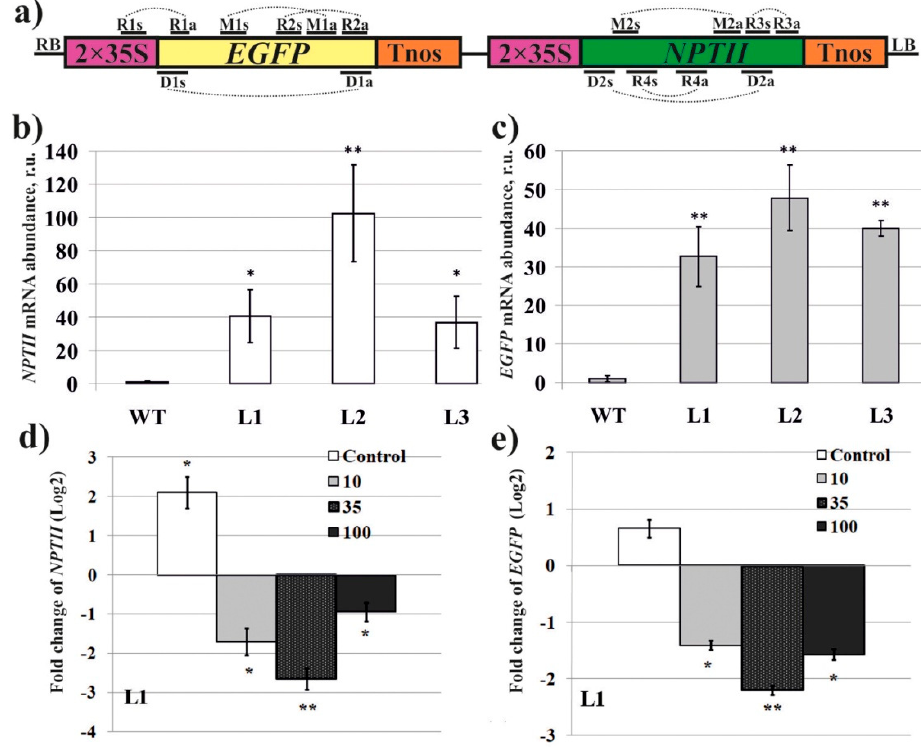
Figure 1. Characterization of transformed A. thaliana lines, and investigation of the dsRNA concentration effect. ( a ) Schematic representation of the T-DNA region from the pZP-RCS2- EGFP - NPTII vector [24]. 2x35S—the double 35S promoter of the cauliflower mosaic virus (CaMV); EGFP —the enhanced green fluorescent protein ( EGFP ) gene; NPTII —the neomycin phosphotransferase II ( NPTII